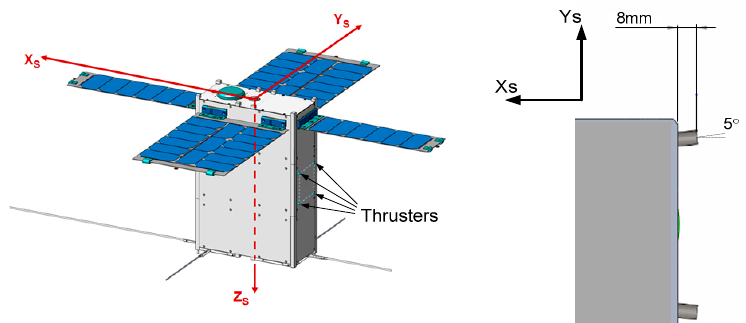
Figure 10. Illustration of the thrusters’ locations and positioning on the Adelis-SAMSON nano-satellites.